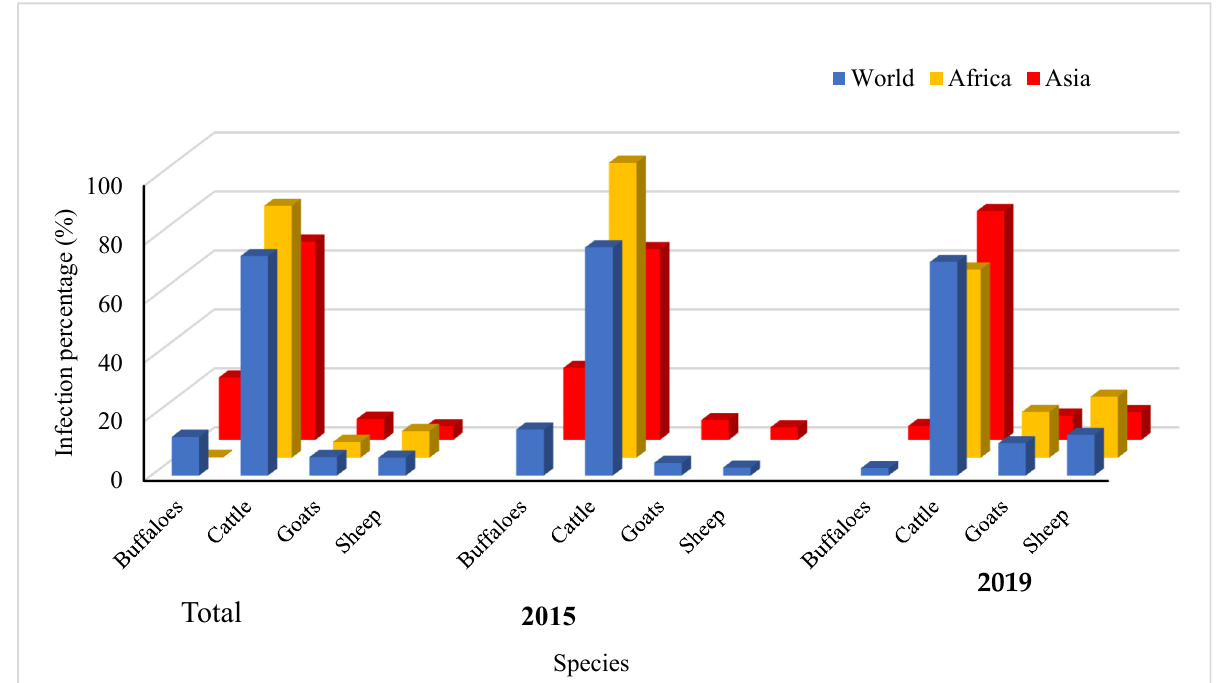
Figure 1. Spatial distribution of HS among buffaloes, cattle, goats and sheep in the period between 2005 and 2019 and total percentage.